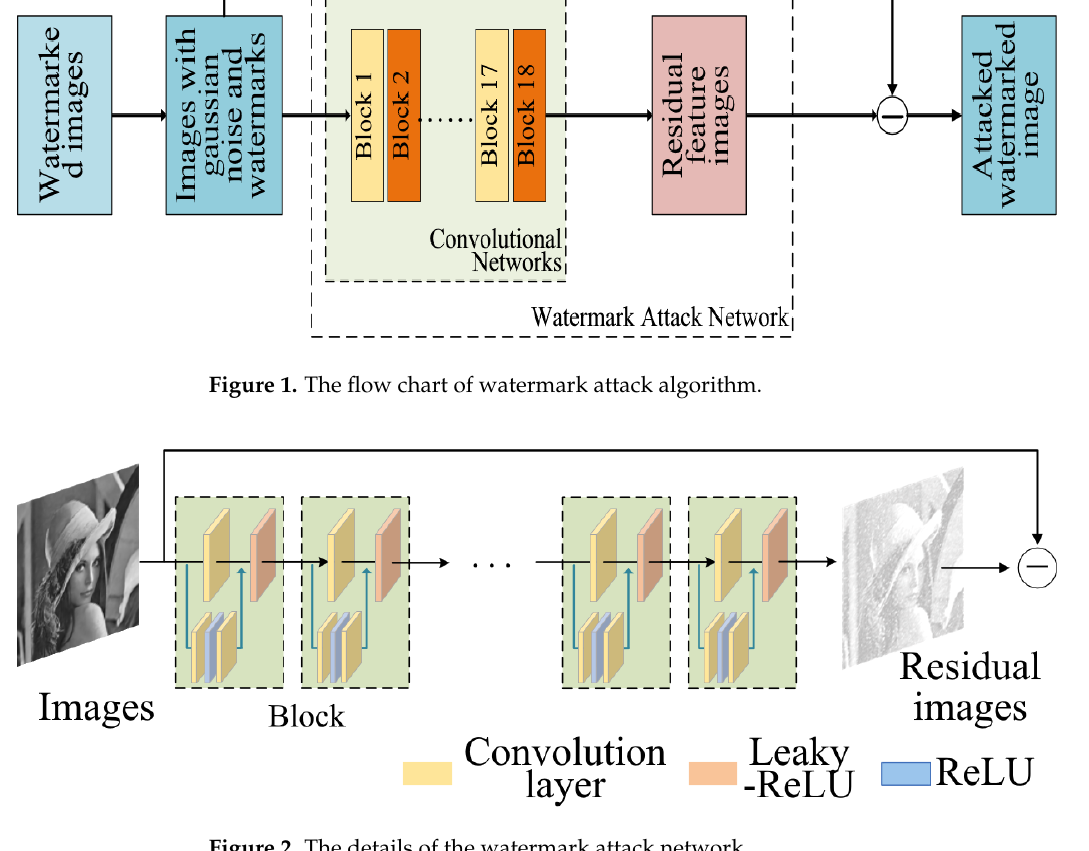
Figure 2. The details of the watermark attack network.